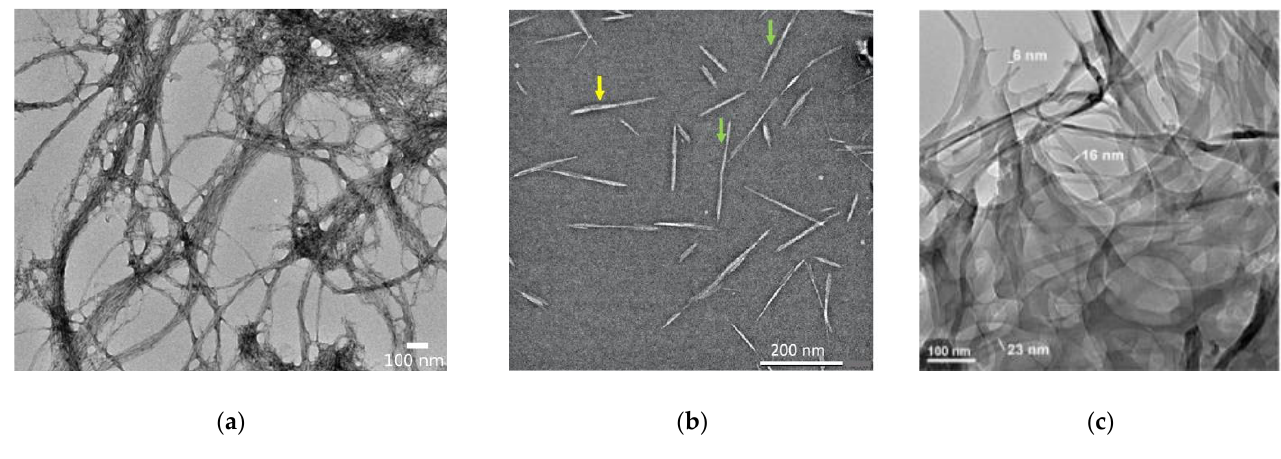
Figure 2. Representative micrographs for each nanocellulose material focused on in this review. Trans- mission electron microscopy (TEM) image of ( a ) CNFs. Reproduced (adapted) with permission [87].